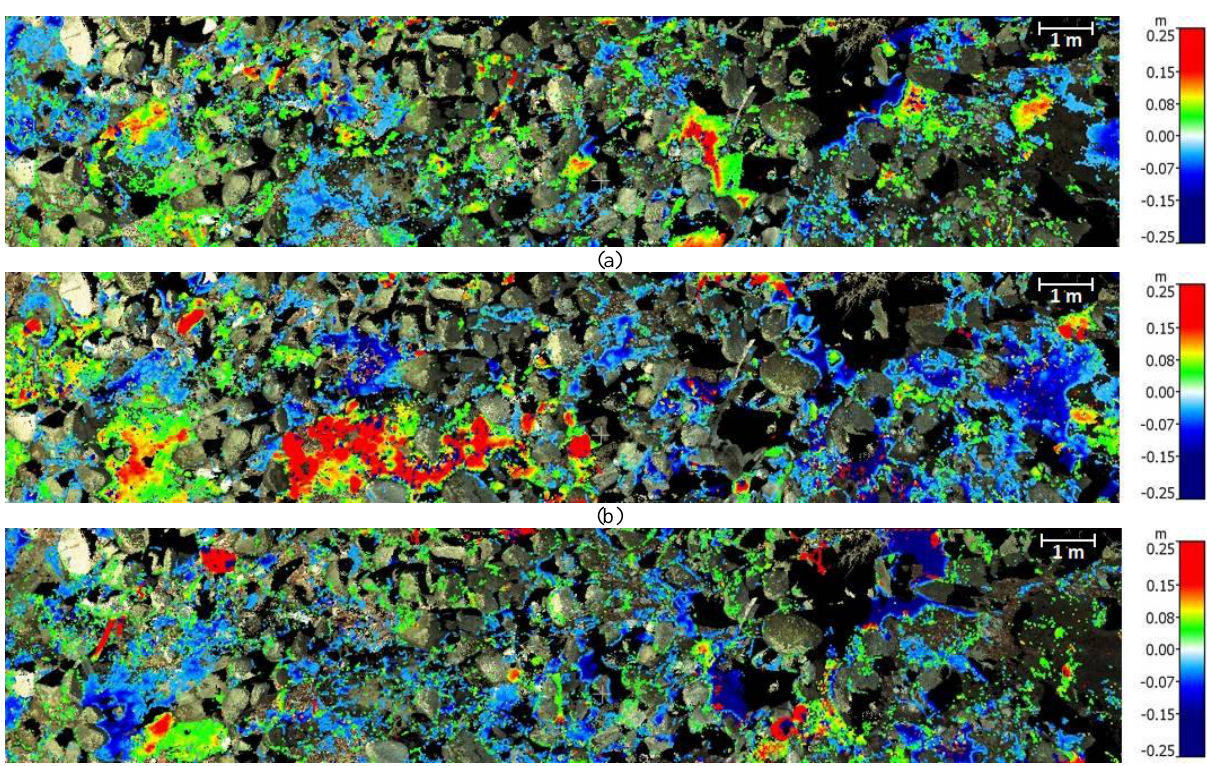
Figure 6. DoD for years: (a) 2012-2011, (b) 2013-2012, (c) 2014-2013 projected over orthoimage; insignificant height differences